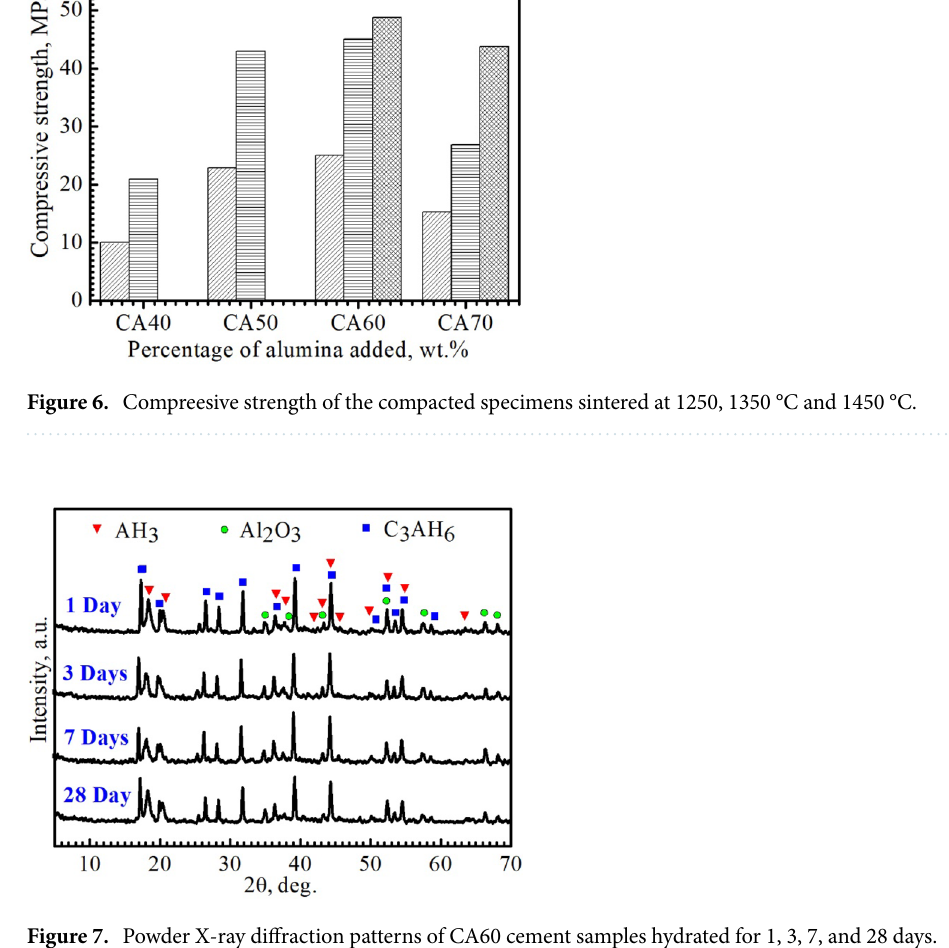
Figure 7. Powder X-ray diffraction patterns of CA60 cement samples hydrated for 1, 3, 7, and 28